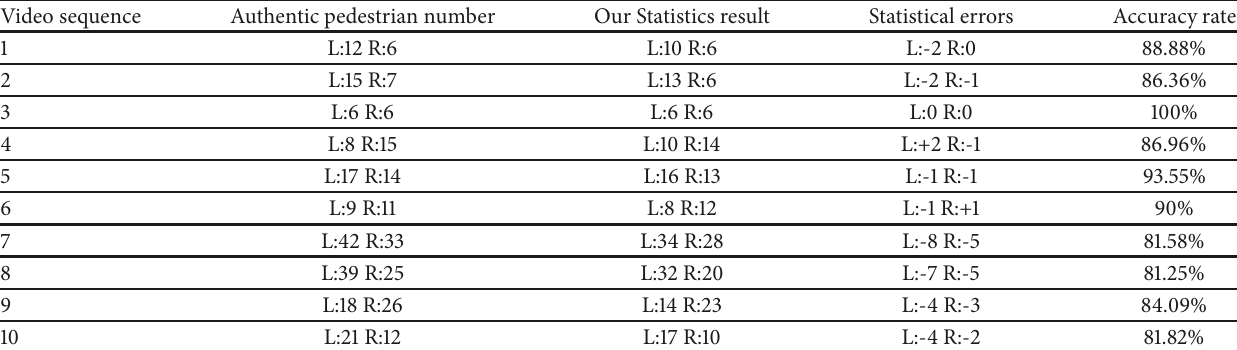
Table 2: The statistics result of pedestrian flow counting.